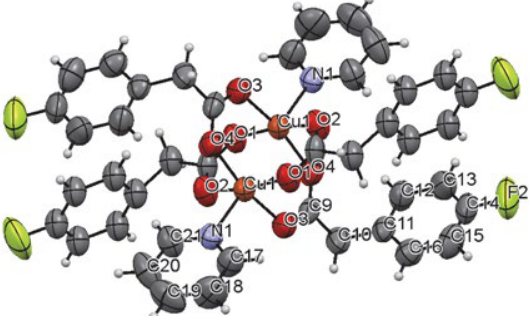
Fig. 1. Structure of the complex tetrakis(4-fluorophenylaceta- to-μ- O , O ’)bis(pyridine- N )dicopper(II) with numbering scheme.